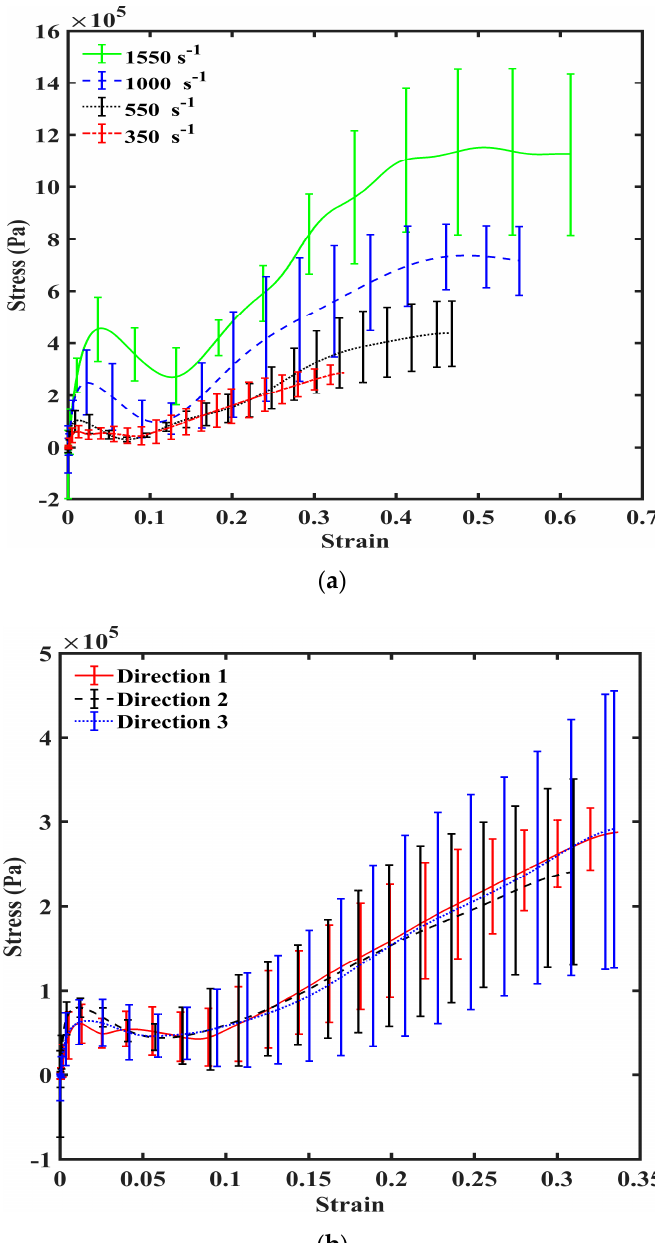
Figure 3. ( a ) True stress–strain response of porcine liver tissue at 350, 550, 1000, and 1550 s − 1 in Direction 1. n = 4 for 350, 550, and 1000 s − 1 ; n = 5 for 1550 s − 1 . Error bars indicate standard deviation. ( b ) Mechanical true stress–strain response of porcine liver tissue at 350 s − 1 in Directions 1, 2, and 3 ( n = 4) illustrating isotropy. Error bars indicate standard deviation.